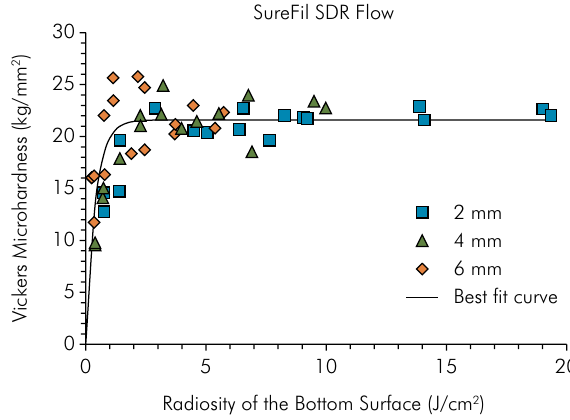
Radiosity of the Bottom Surface (J/cm 2